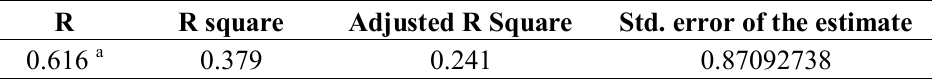
Table 3a. Summary of regression model.